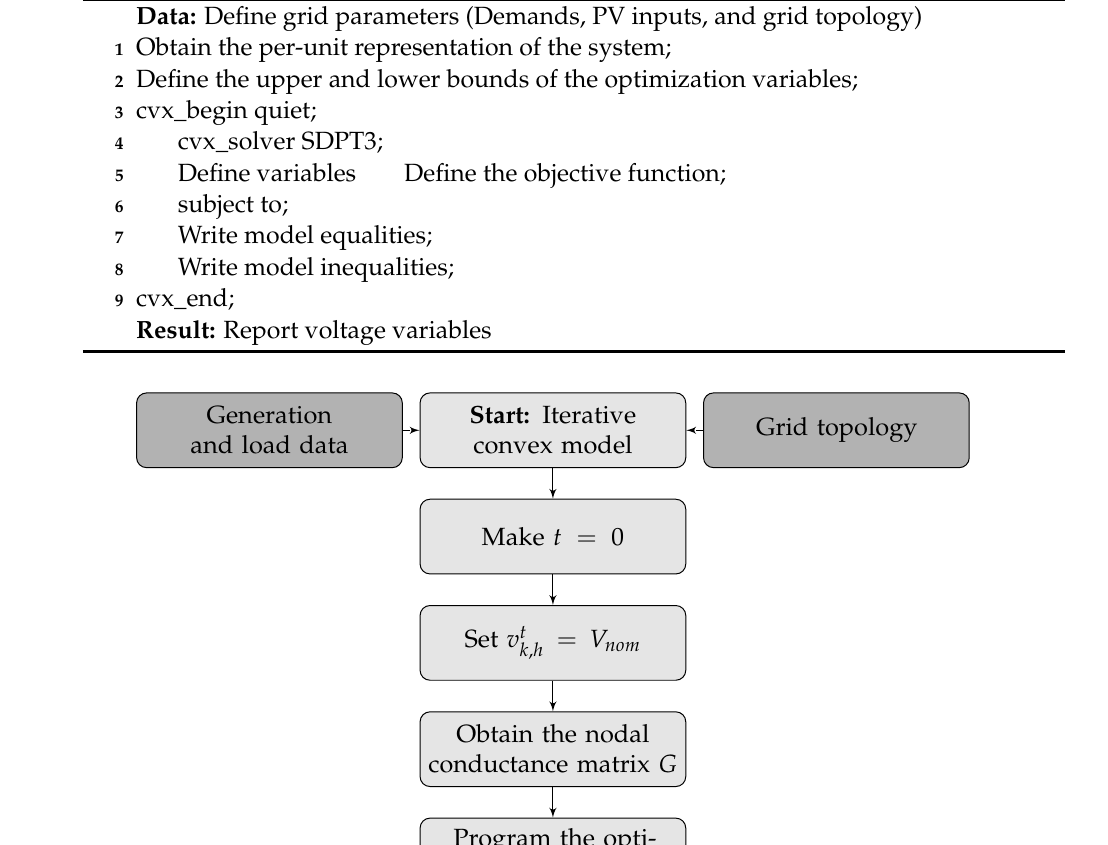
Algorithm 1: Implementation of the approximated convex model (17) in the CVX environment of MATLAB.